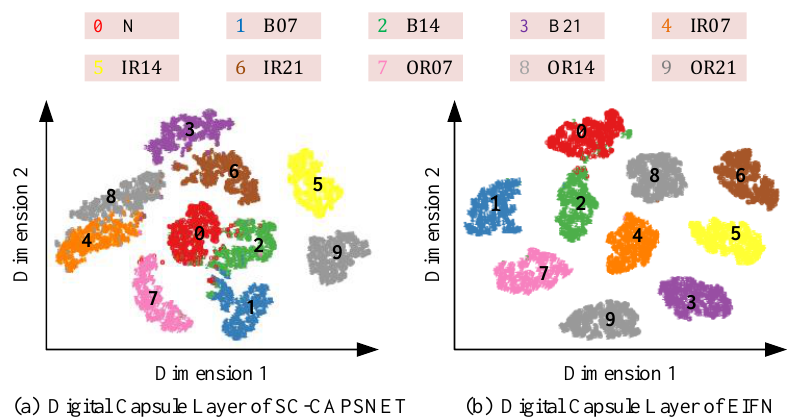
Figure 16. The feature visualization of digital capsule layer.